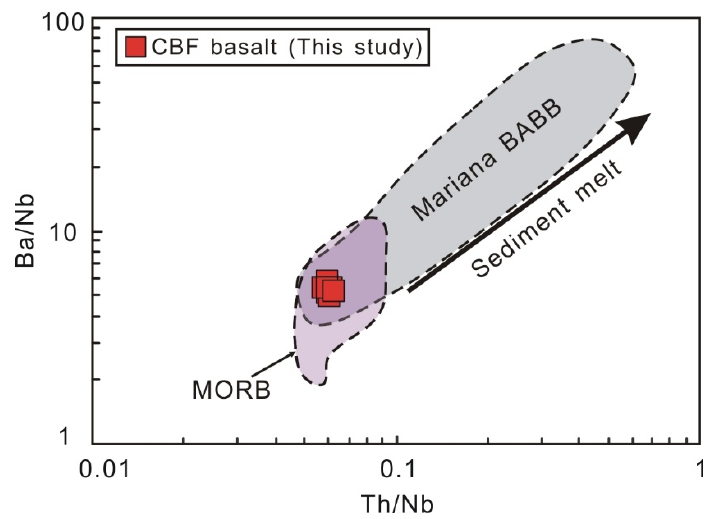
Figure 8. Ba/Nb vs. Th/Nb diagram [55] for basalts from CBF in the WPB.